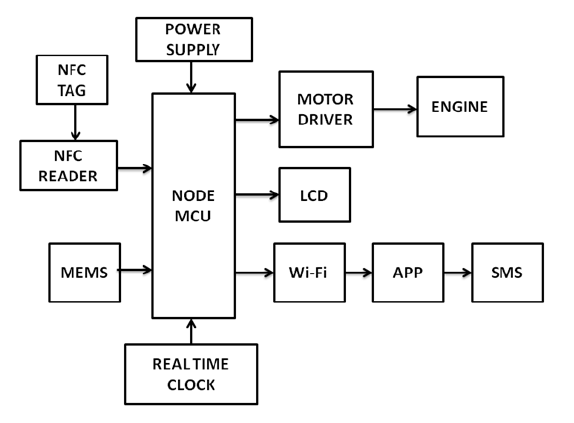
Fig.1. Data flow diagram represents the flow of data and control in the